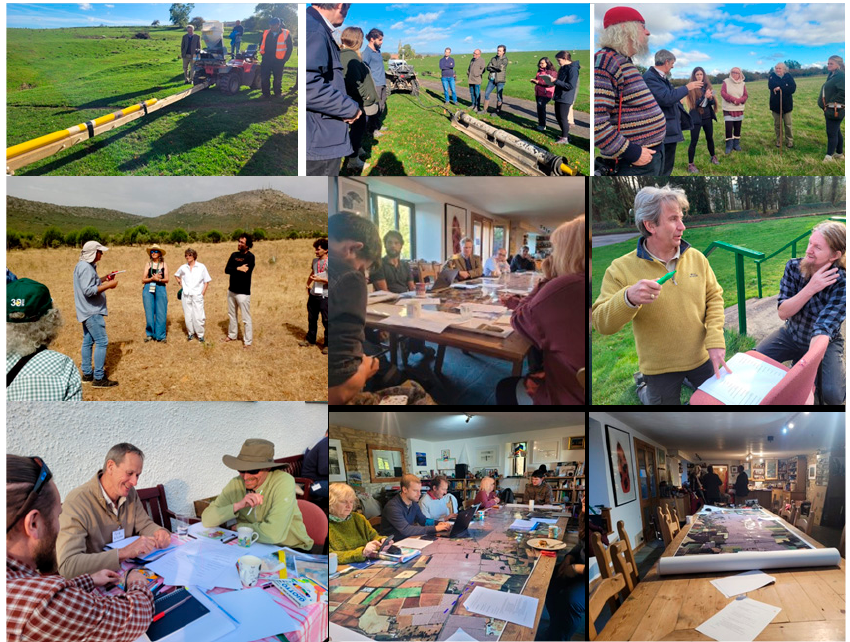
Figure 2. Participants in ipaast project workshops provided information on their needs as data users, current practices in their work, and their views on the challenges and potential of working together.